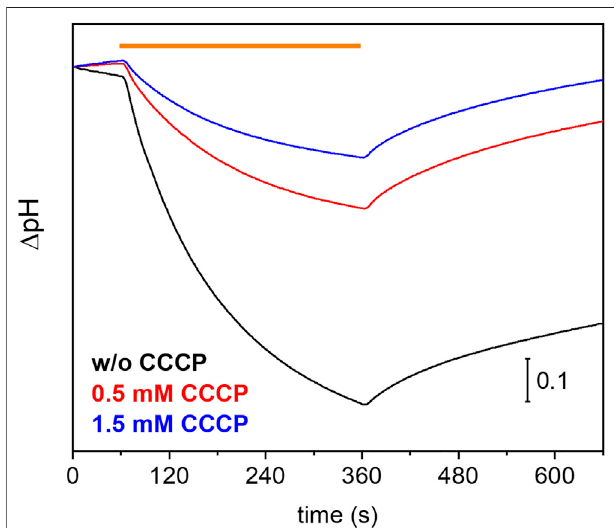
FIGURE 1 | Proton-pumping assay on Pichia cells. Comparison of pH changes during and after 5 min of illumination (indicated by orange bar) of Um Rh1 expressing P. pastoris cells in 100 mM NaCl in the absence (black trace)andthepresenceof0.5 mM(redtrace)and1.5 mMofCCCP(blue trace) as